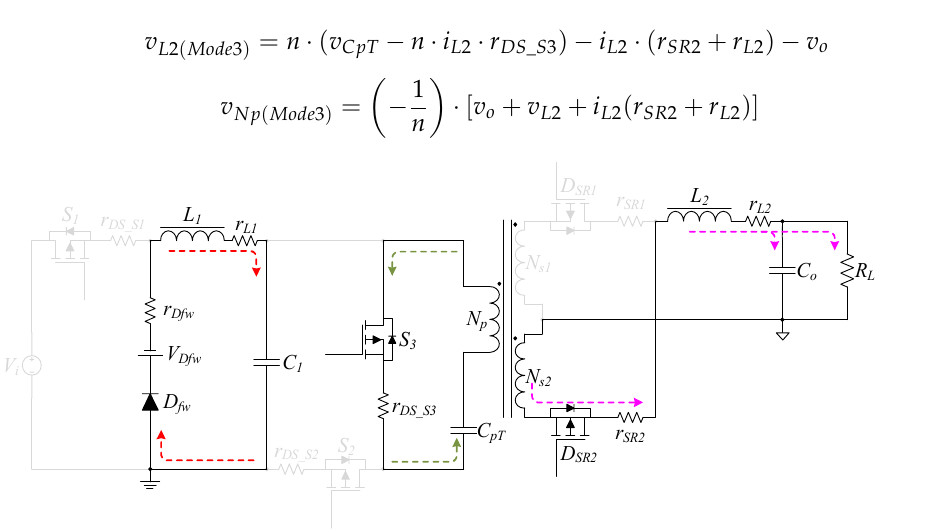
3 is in the turned-on state. The inductor L 1 keeps